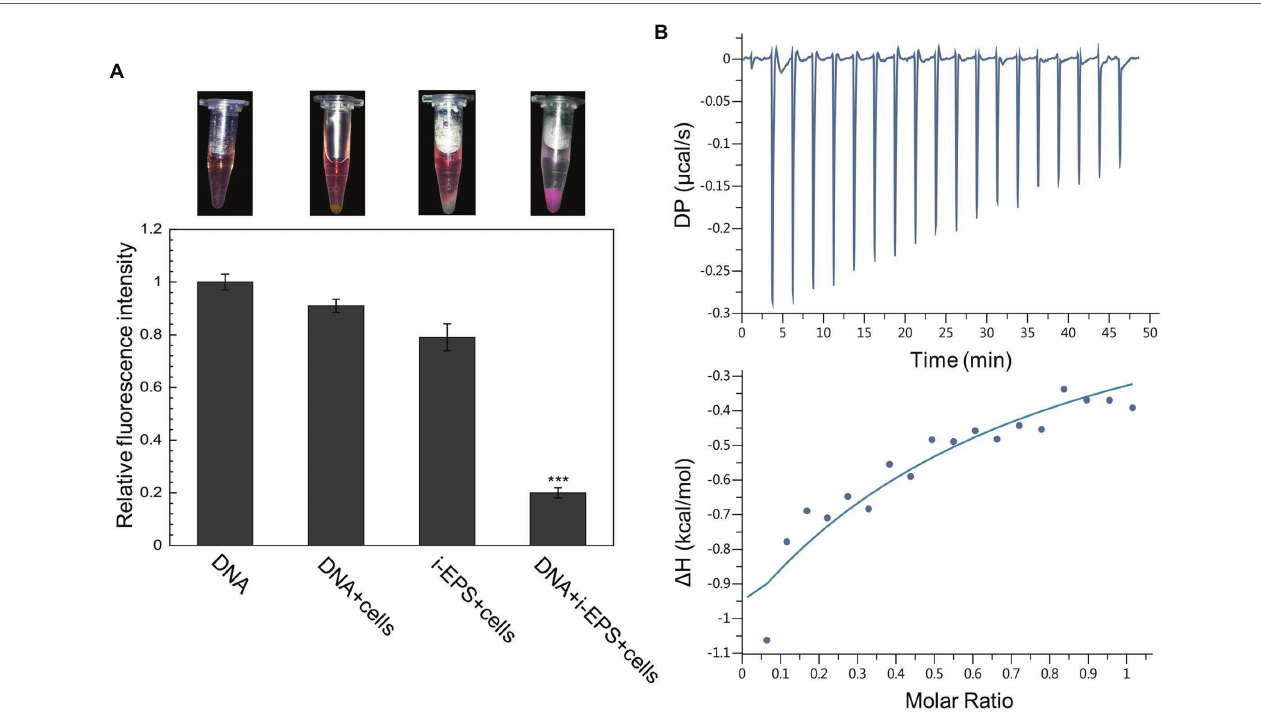
FIGURE 2 | DNA interacts with both i- and s-EPS of Myxococcus xanthus in vitro . (A) Result of the precipitation assay. The representative photograph of the sample after centrifugation is shown in the upper panel. The fluorescence intensity of the supernatant was measured at an excitation wavelength of 518 nm and an emission wavelength of 620 nm (lower panel; n = 3; *** p < 0.001). (B) Isothermal titration calorimetry (ITC) profile for the titration of s-EPS with DNA. The upper panel represents the raw data for the sequential injections of s-EPS into DNA solution, and the lower panel shows the integrated and dilution-corrected data peak area plotting of the titration